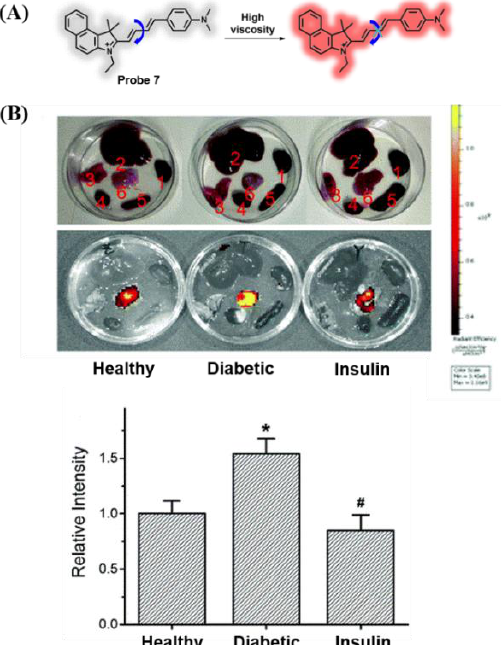
Figure 5. ( A ) Imaging mechanism of probe 7 ; ( B ) distribution of organ fluorescence in three groups, λ ex / em = 570/700 nm, * p < 0.05, # p < 0.05. Adapted from Reference [61]. Copyright 2021, the Royal Society of Chemistry.